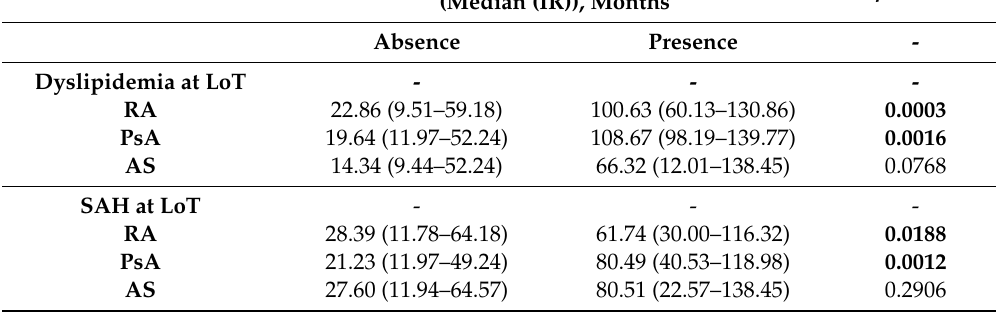
Table 6. E ff ect of the development of dyslipidemia or systemic arterial hypertension (SAH) during the bDMARD treatment (registered at the LoT visit) on the retention rate of the bDMARD, stratified according to the